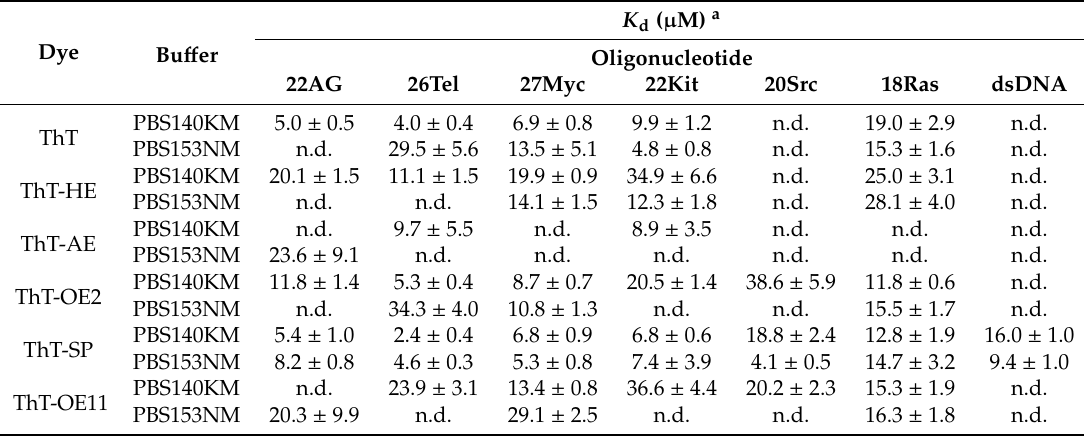
Table 2. Binding a ffi nities of ThT and its analogs for the target oligonucleotides.